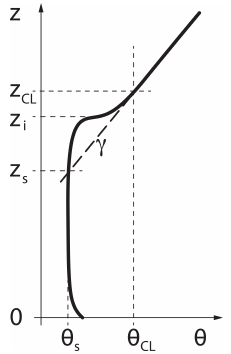
Figure 4. Idealized potential-temperature profile θ vs. height with constant stable-layer lapse rate γ